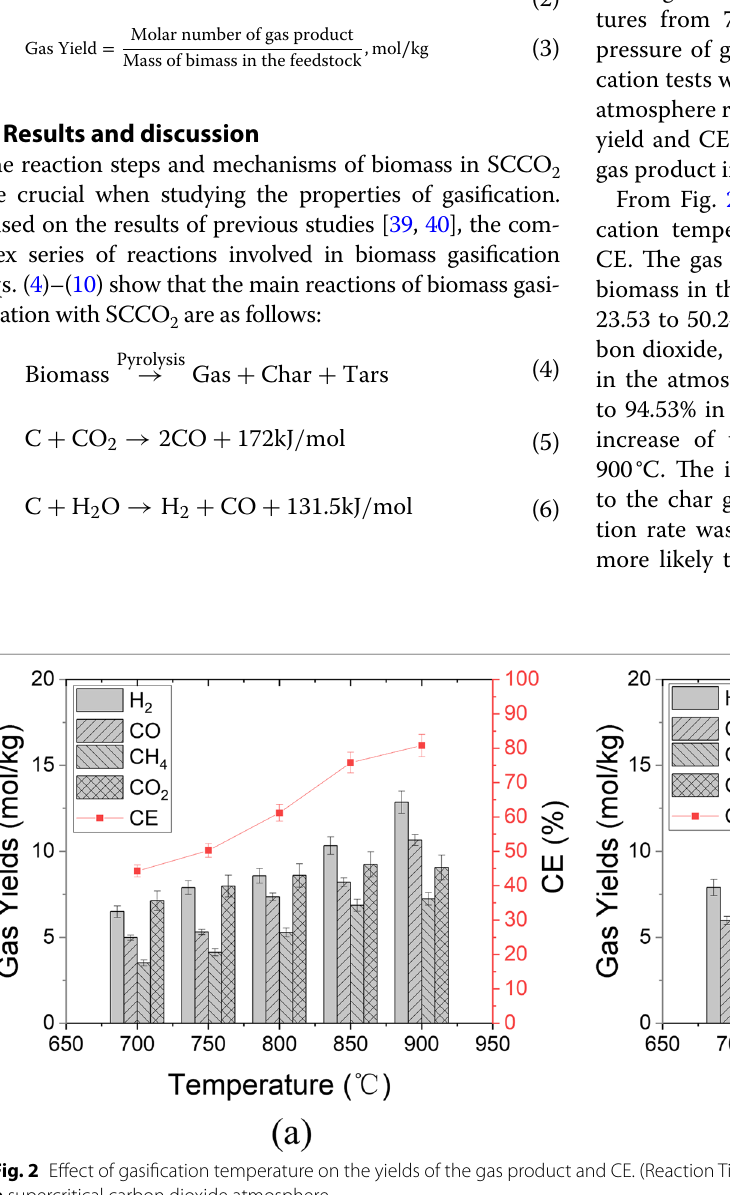
Fig. 2 Effect of gasification temperature on the yields of the gas product and CE. (Reaction Time b supercritical carbon dioxide